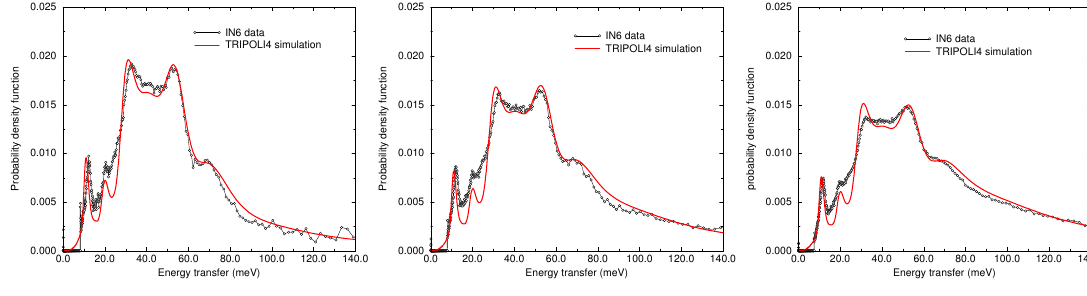
Figure 4. (Color online) Experimental and theoretical PDOS for UO 2 at 300 K, 600 K and 900